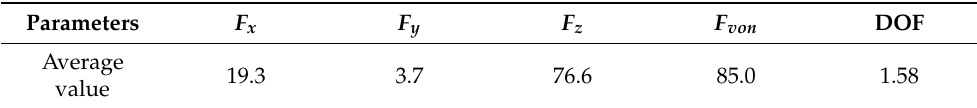
Figure 6. Schematic diagram of node selection location. Table 3. Residual stress and deformation of base metal.